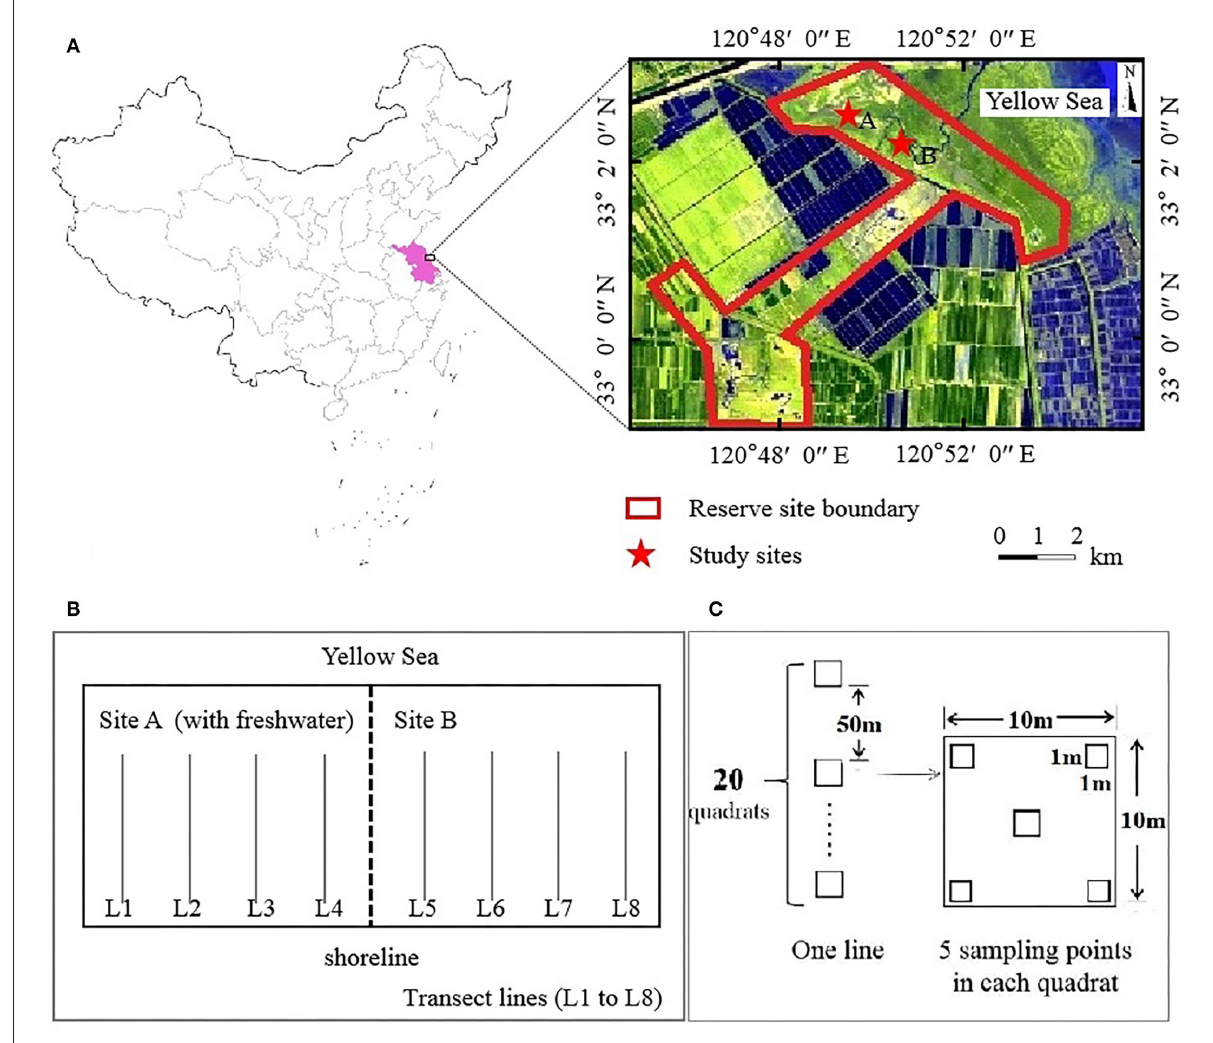
FIGURE1 Location of the study sites. Reserve site (A) , transect lines design (B) , quadrat design (C)